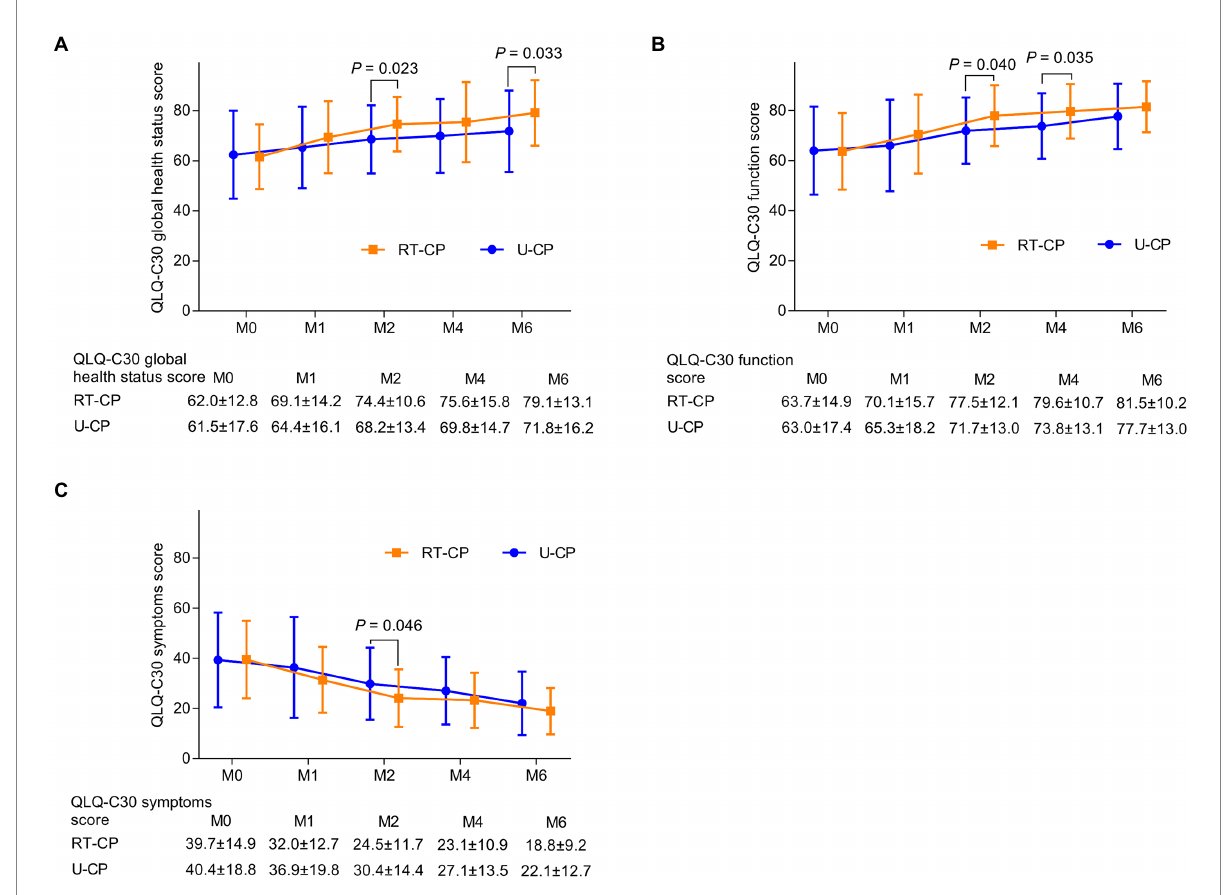
FIGURE 3 Comparison of QLQ-C30 score at different time points between RT-CP group and U-CP group. QLQ-C30 global health score at M2 and M6 was increased in the RT-CP group compared with the U-CP group (A) ; QLQ-C30 function score at M2 and M4 was elevated in the RT-CP group compared to the U-CP group (B) ; QLQ-C30 symptom score at M2 was reduced in the RT-CP group in contrast with the U-CP group (C) .